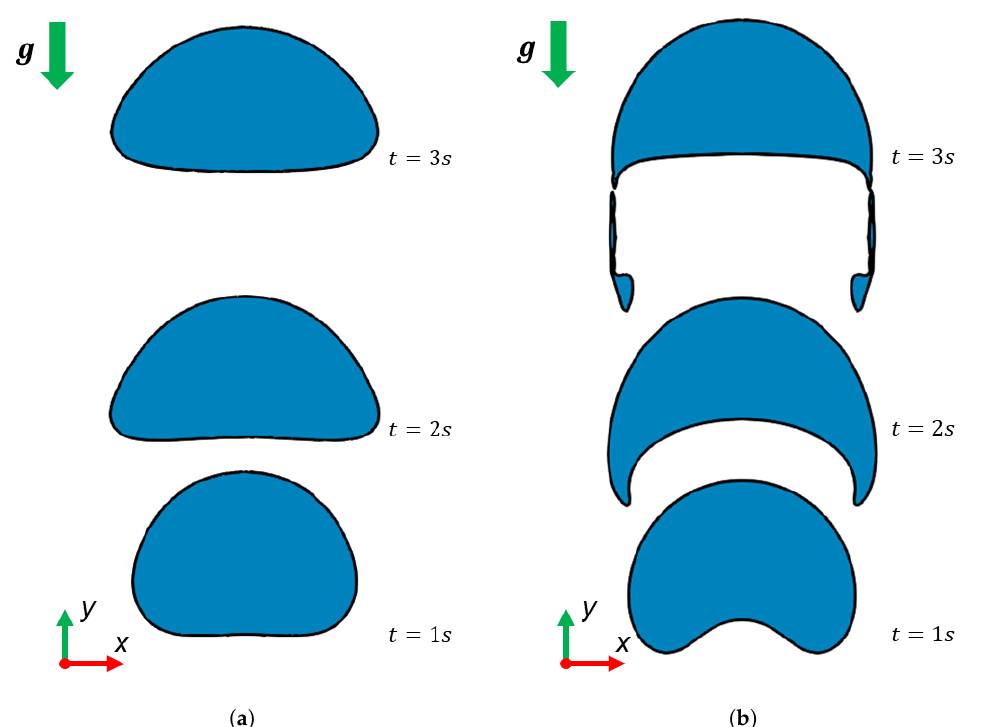
Figure 5. 2D bubble shape evolution for the C1 ( a ) and C2 ( b ) scenario represented through contour r α = 0.5.